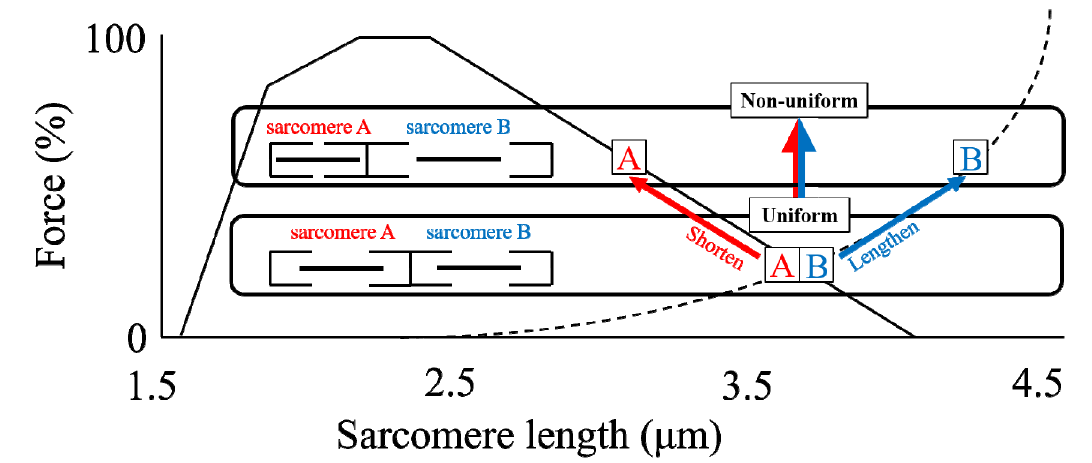
Figure 4. Schematic diagram of two (1) uniform (in length) sarcomeres (lower) and (2) non-uniform (in length) sarcomeres (upper) on the descending limb of the force-length relationship. These two sarcomeres are stabilized because they have the same force-generating capability for both conditions. Note that even though the sum of the length of sarcomeres A and B is identical between the two conditions, the force produced by these conditions is different.